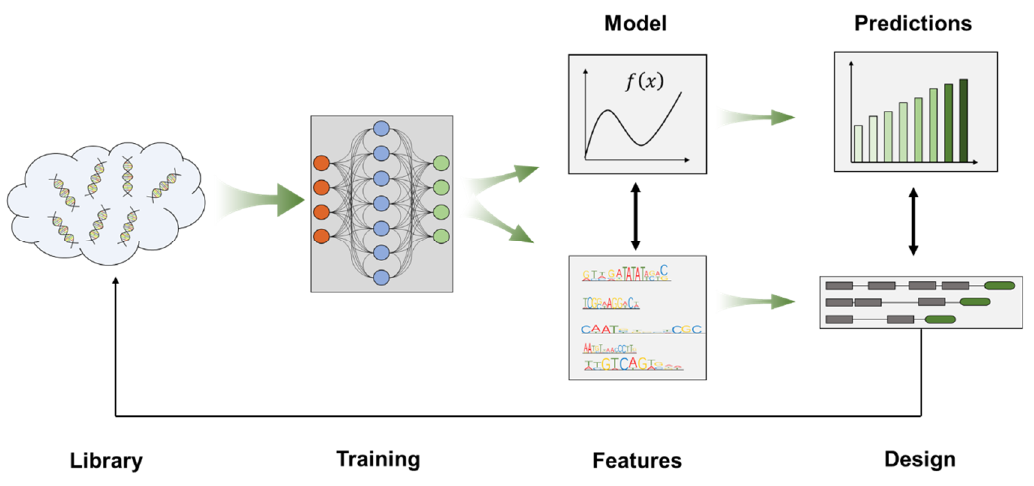
Figure 2. Machine learning procedures including database building, training, feature extraction Figure 2. Machinelearningproceduresincludingdatabasebuilding, training, featureextraction(modeling), (modeling), design (prediction) and verification. design (prediction) and